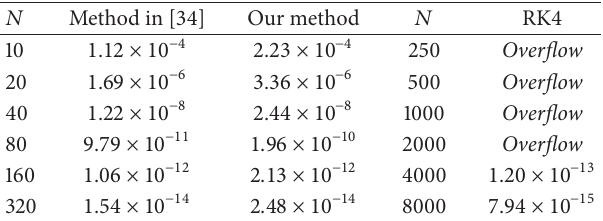
Table 8: Comparison of methods for Example